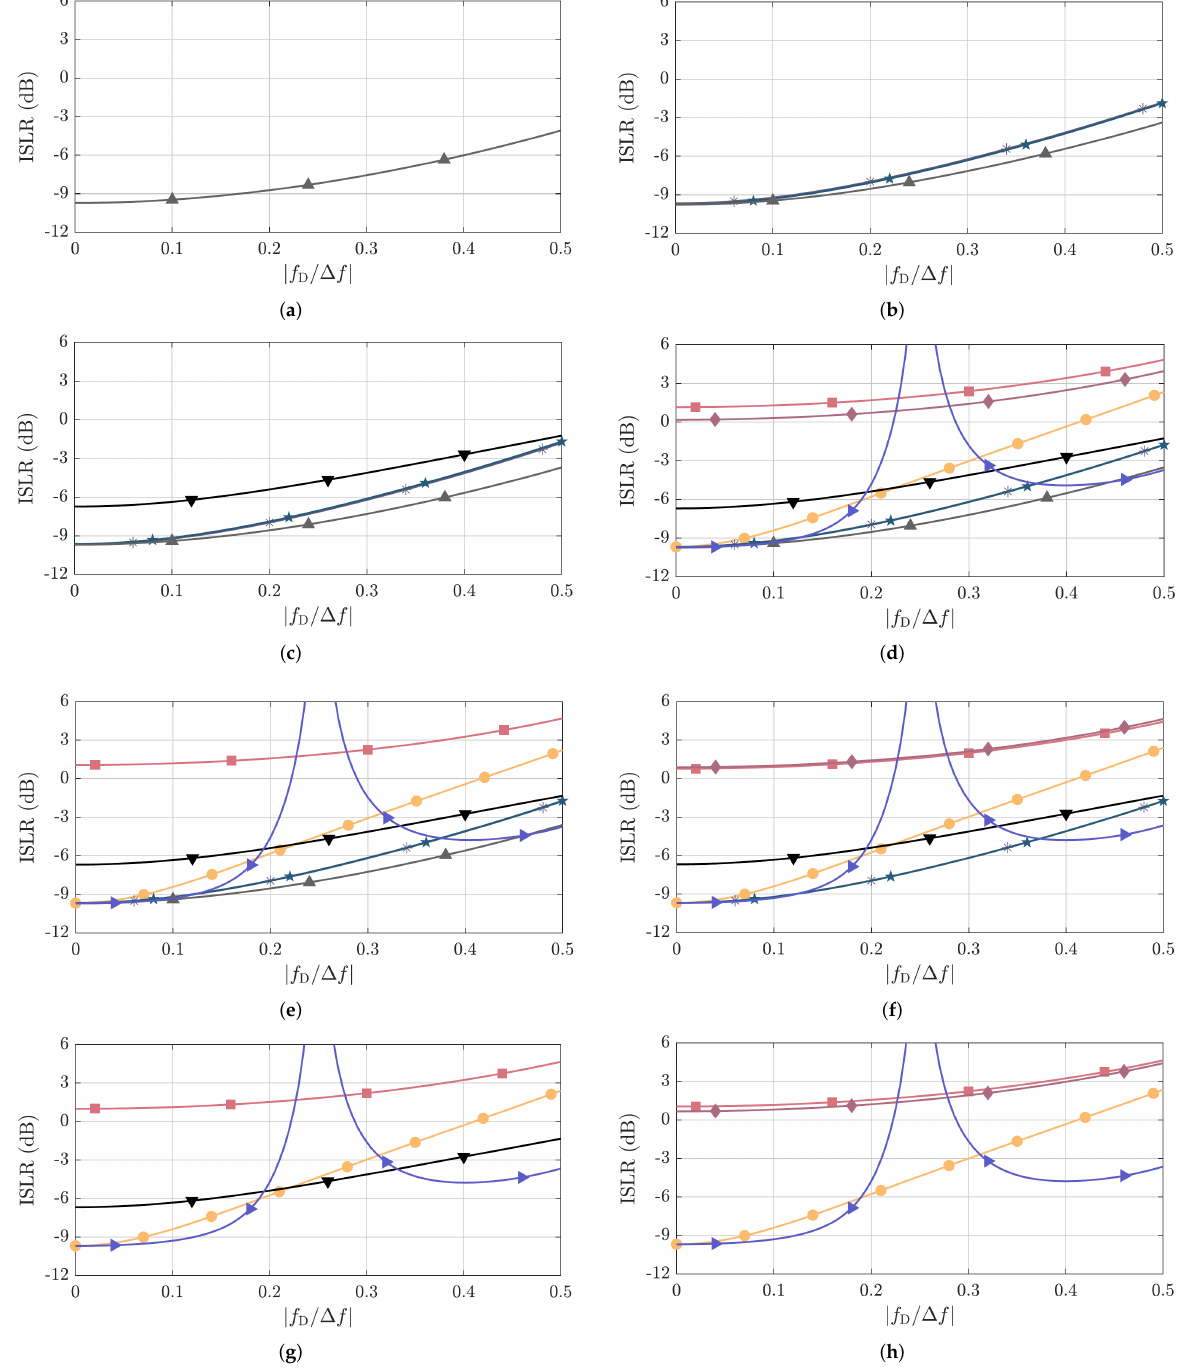
Figure 11. Simulated ISLR as a function of f D / ∆ f for the considered PRBSs with approximate PACF usable length of ( a ) N PRBS,usable = 32, ( b ) N PRBS,usable = 64, ( c ) N PRBS,usable = 128, ( d ) N PRBS,usable = 256, ( e ) N PRBS,usable = 512, ( f ) N PRBS,usable = 1024, ( g ) N PRBS,usable = 2048, and ( h ) N PRBS,usable = 4096. The considered PRBSs are m-sequence ( ), Gold sequence ( (cid:4) ), Kasami (cid:32) sequence ( (cid:7) ), APAS ( (cid:72) ), ZCZ sequence ( (cid:78) ), Golay A ( ), Golay B ( (cid:70) ), and the combination of (cid:66) complementary sequences Golay A and B ( (cid:73) ). The correspondence between their N PRBS,usable and N PRBS values is listed in Table